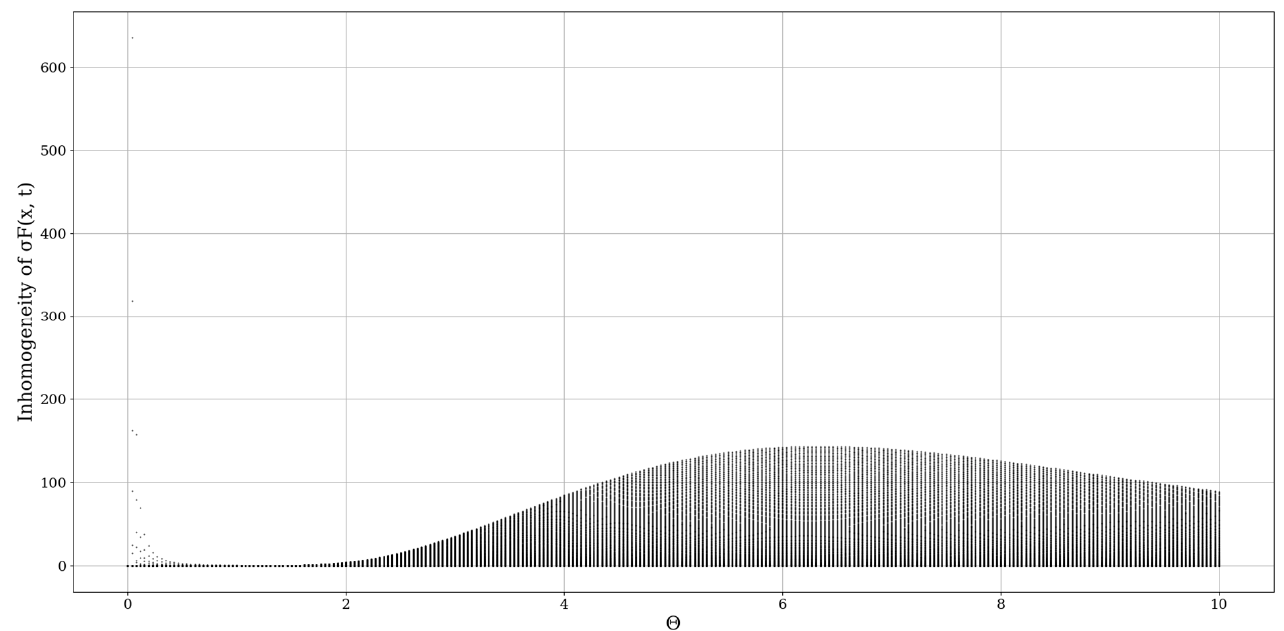
Figure 10. 〈|σ (cid:2890) (cid:3364)(cid:3364)(cid:3364)| (cid:4593)(cid:2870) 〉 example plot with θ as control parameter; ξ = 3 ; μ = 3 .